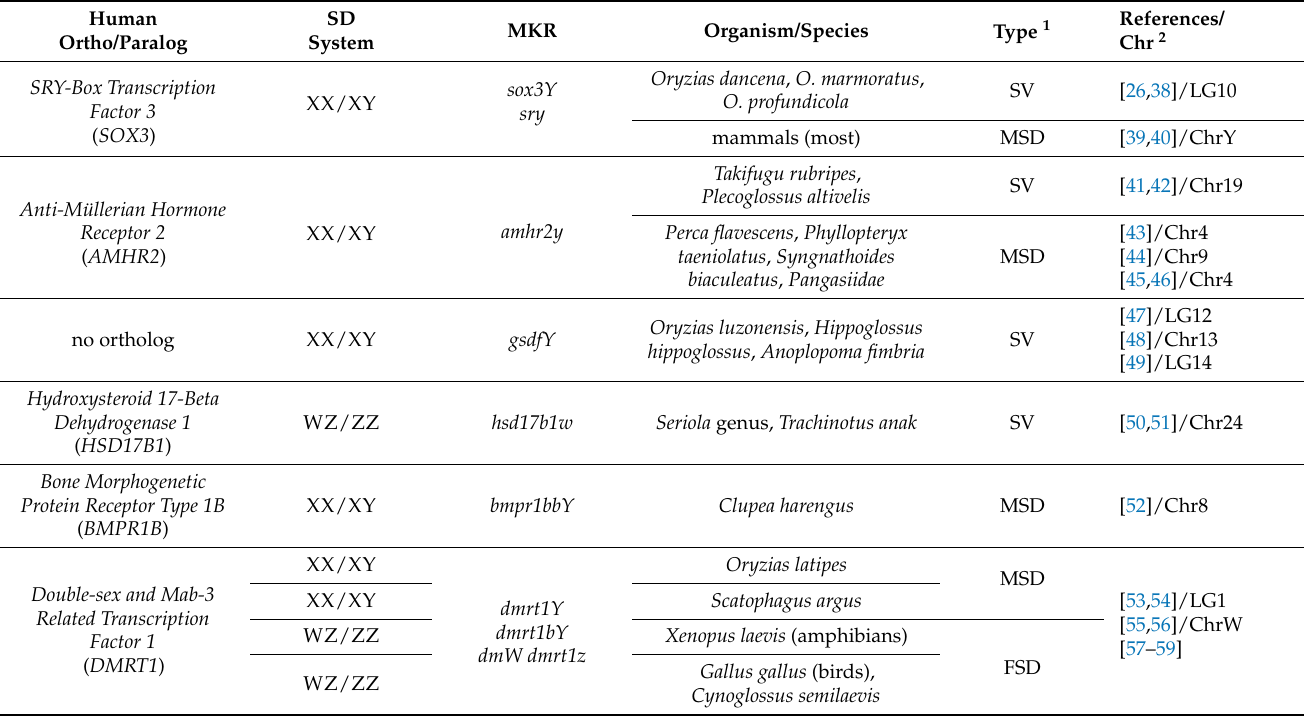
Table 1. Identification of Master Key Regulators (MKRs) of Sex Determination (SD) and their paralogs. Human